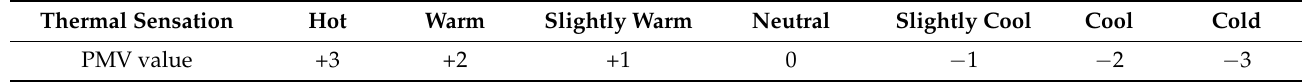
Table 7. Predicted mean vote